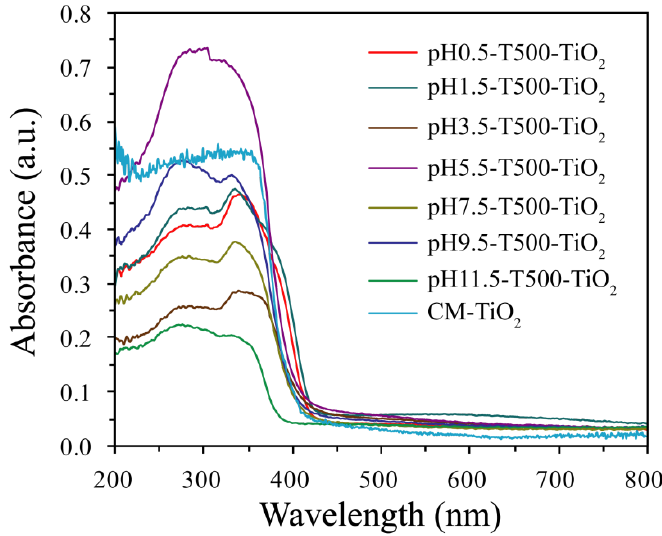
Figure 6. UV-Vis diffuse reflectance spectra of the pH x − T500 − TiO 2 and CM − TiO 2 samples.